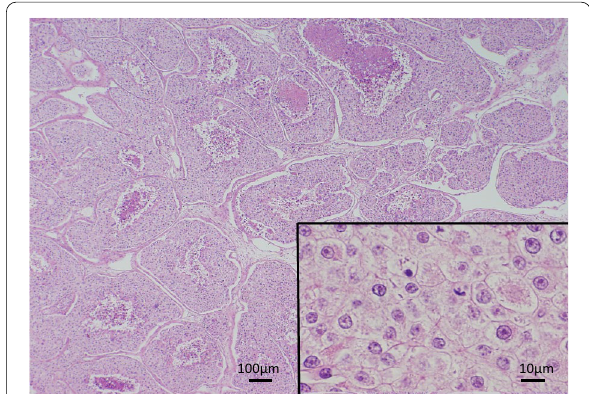
Fig. 4 Histology of the metastatic pancreatic tumor. The tumor, composed of large nests, invades the pancreas. The tumor cells have large round vesicular nuclei, prominent nucleoli, and pale eosinophilic granular